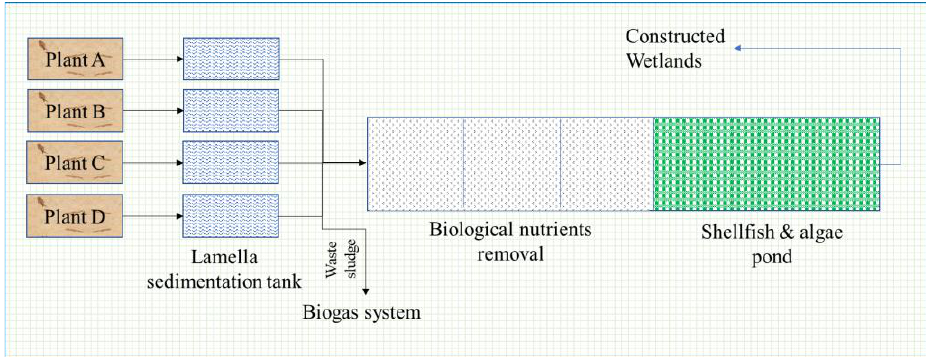
Figure 4. Wastewater treatment technology of small-scale mariculture plants.